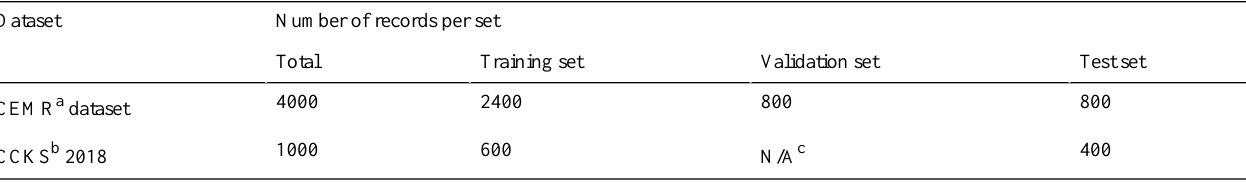
Table 2. Components of the two datasets.